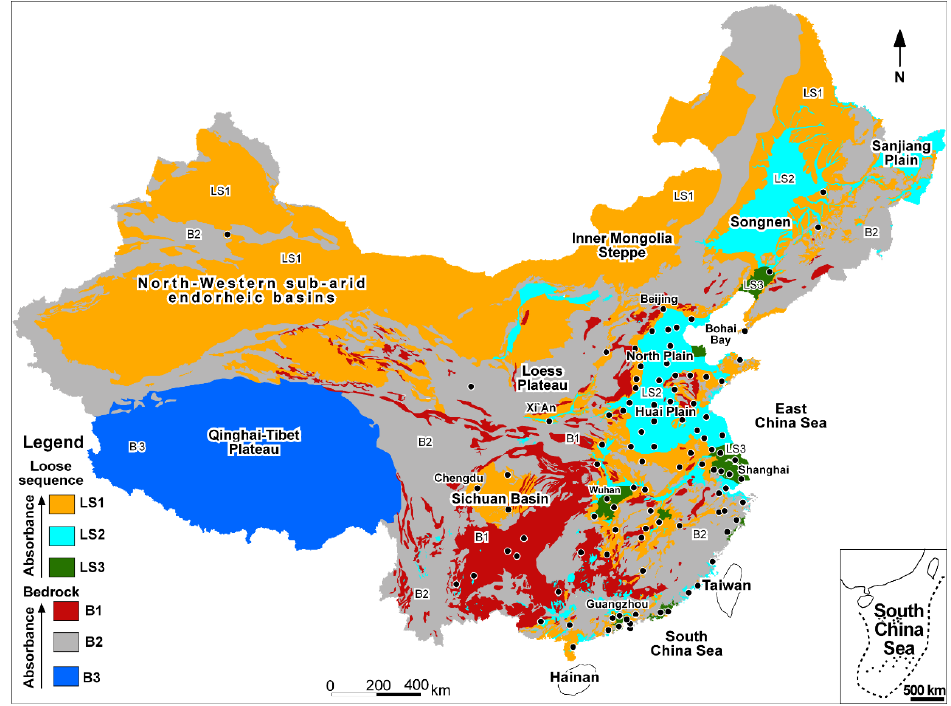
Figure 5. Absorbance potential map of China based on hydrogeological and geomorphological criteria. Key to the legend: piedmonts, desertic endorheic basins, alluvial fans, hilly terrains, incised alluvial terraces (LS1); main alluvial plains and valleys, seasonally flooded karst depression (LS2); deltas and lacustrine basins (LS3); karst bedrock (B1); outcrop bedrocks, weathered blankets, and minor alluvial valleys (B2); permafrost and frozen soils (B3). Black dots indicate top 100 most populous cities of China.